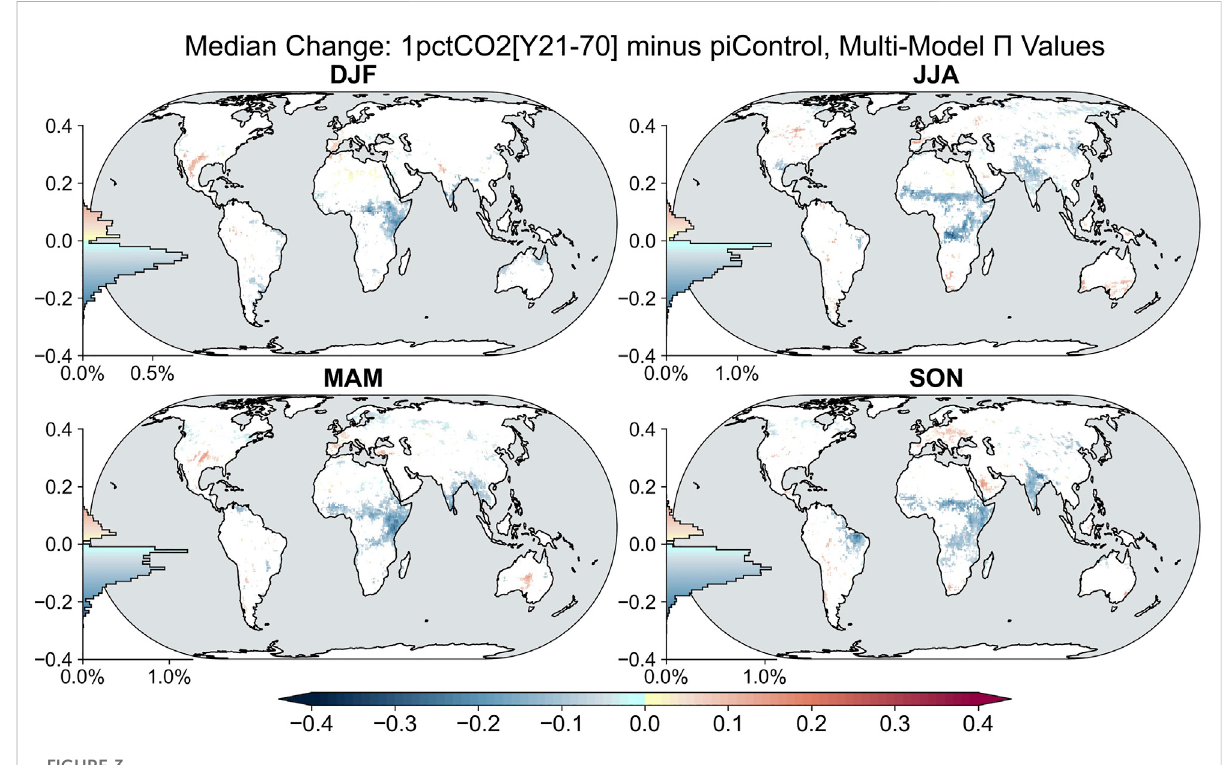
FIGURE 3 As in Figure 2 for the median change in Π (dimensionless) from piControl to years 21 – 70 of the 1pctCO2 simulations (leading up to a doubling of CO 2